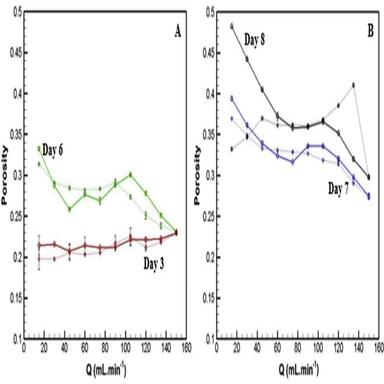
Evolution of biomass porosity over feed flow rate at different times of biofilm growth obtained after application of compression (solid line, red error bars) and decompression (dotted line, black error bars) on the filtration system. (For interpretation of the references to color in this figure legend, the reader is referred to the Web version of this article.)